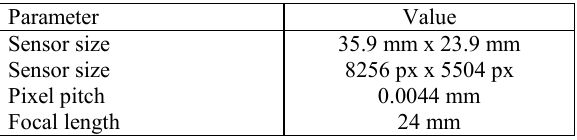
Table 2. Nikon D850 specification